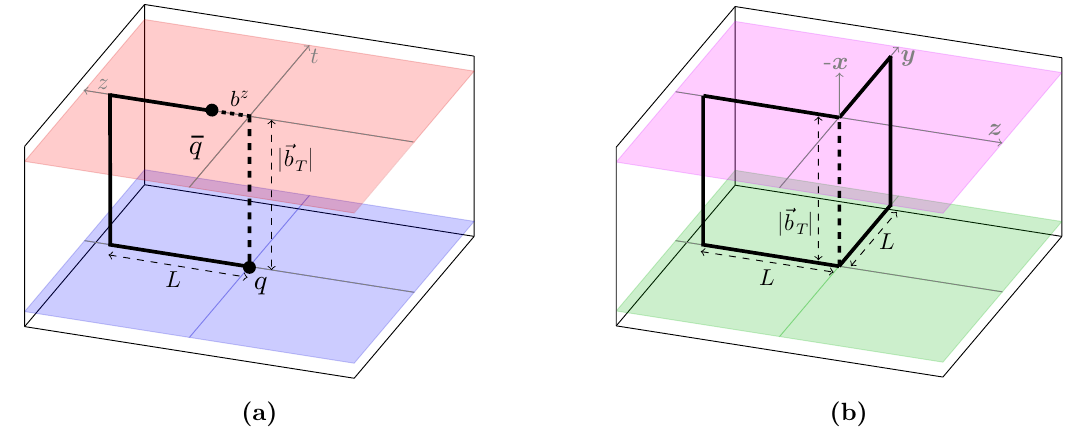
Figure 2. Illustration of the Wilson line structure of the quasi beam function ~ B q (a) and the bent quasi soft function ~ S q (b), as given in eqs. (2.8) and (2.10). Note the di(cid:11)erent coordinate systems bent in the two (cid:12)gures: (a) is shown in ( z; t; x ) space, while (b) is shown in ( z; y; x ) space. In both cases, ~b T is aligned along the x